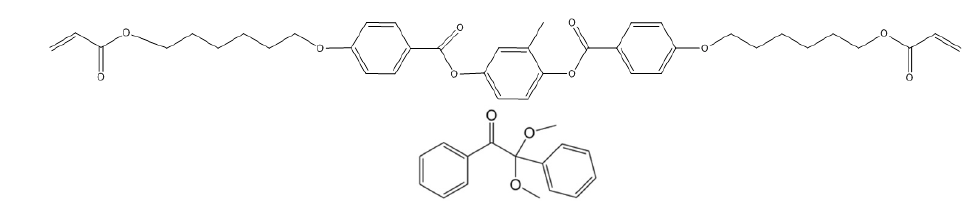
Figure 3. Materials used for PSLC compositions. 117